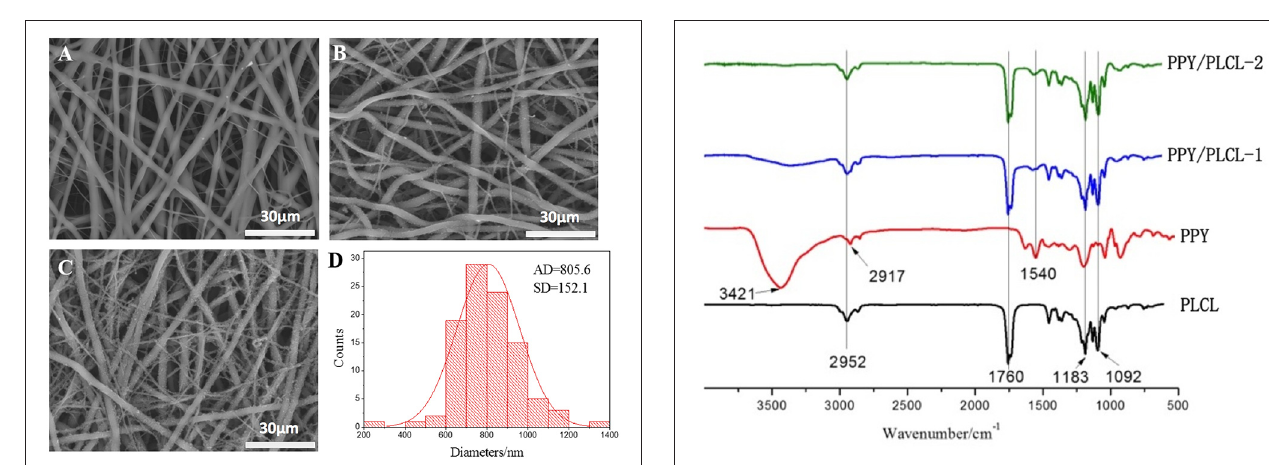
FIGURE 1 | The scanning electron microscope images of electrospun nanofibers. (A) Poly (l-lactic acid-co- ε -caprolactone) (PLCL) nanofibers; (B) Polypyrrole (PPY)/PLCL-1 nanofibers; (C) PPY/PLCL-2 nanofibers; (D) diameter distribution of PLCL/PPY-2 nanofibers (AD: average diameter).